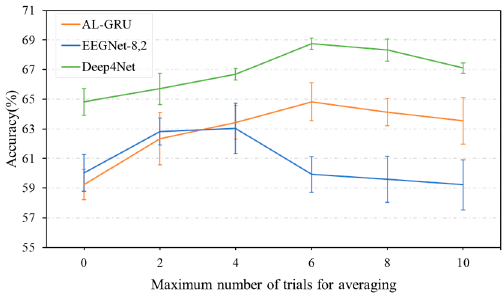
Figure 6. Confusion matrices of AL-GRU and benchmark models. The color scale reveals the classification accuracies. AL-GRU-4 stands for four-layer stacked AL-GRU with skip connections.